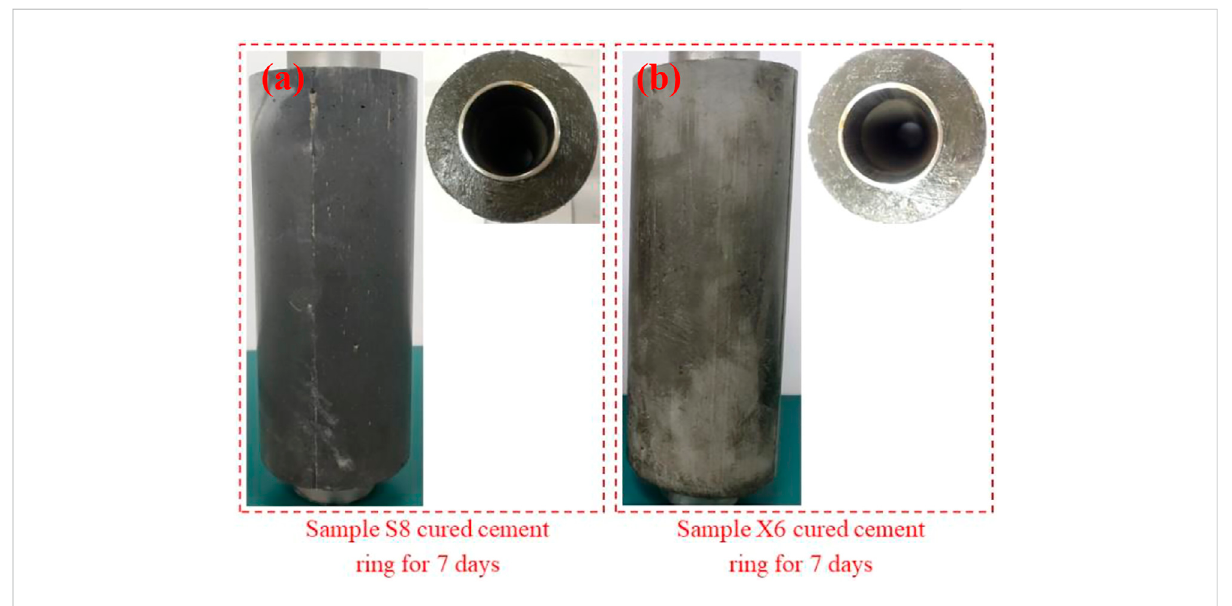
FIGURE 13 Macro morphology of cement sheath after curing at 60C for 7